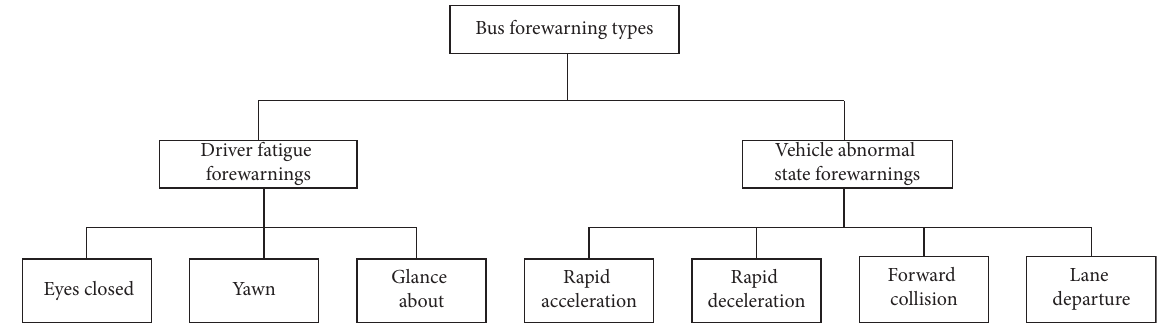
Figure 2: Classification of forewarning types. Table 2: Weather and period of the retrieval